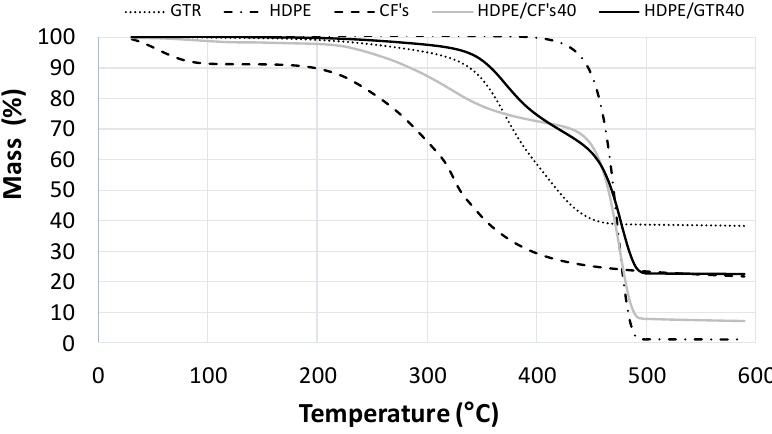
Figure 9. Thermograms of GTR/HDPE and CFs/HDPE composites at 40% composition and their corresponding components separately (EVA, GTR and CFs).